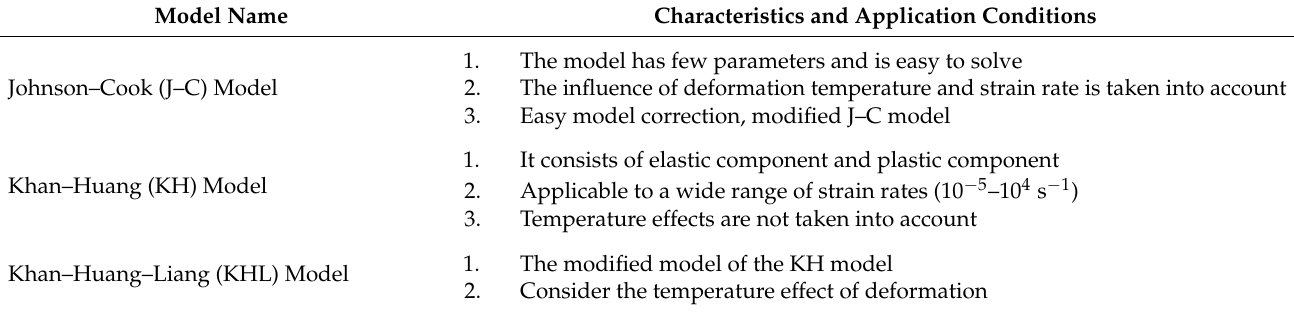
Table 1. The characteristics of the phenomenological constitutive